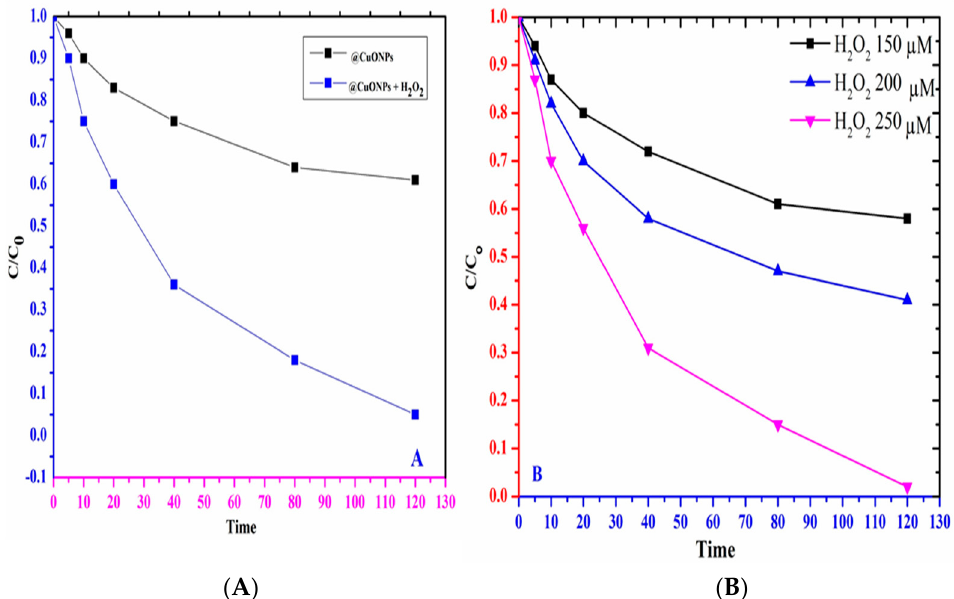
Figure 9. ( A ) Effect and removal of CR dye by UV/ H 2 O 2 ; ( B ) Effect of H 2 O 2 concentration in the degradation of CR dyes.